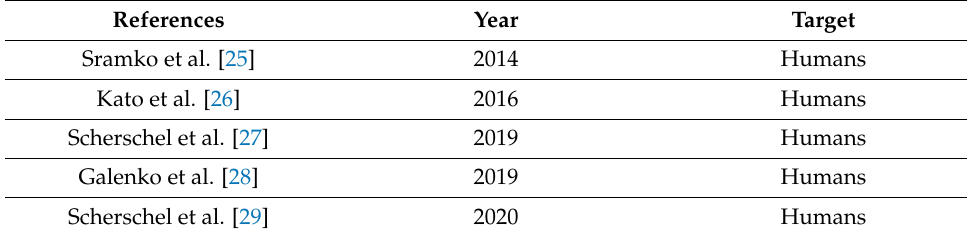
Table 1. Studies evaluating S100 proteins.